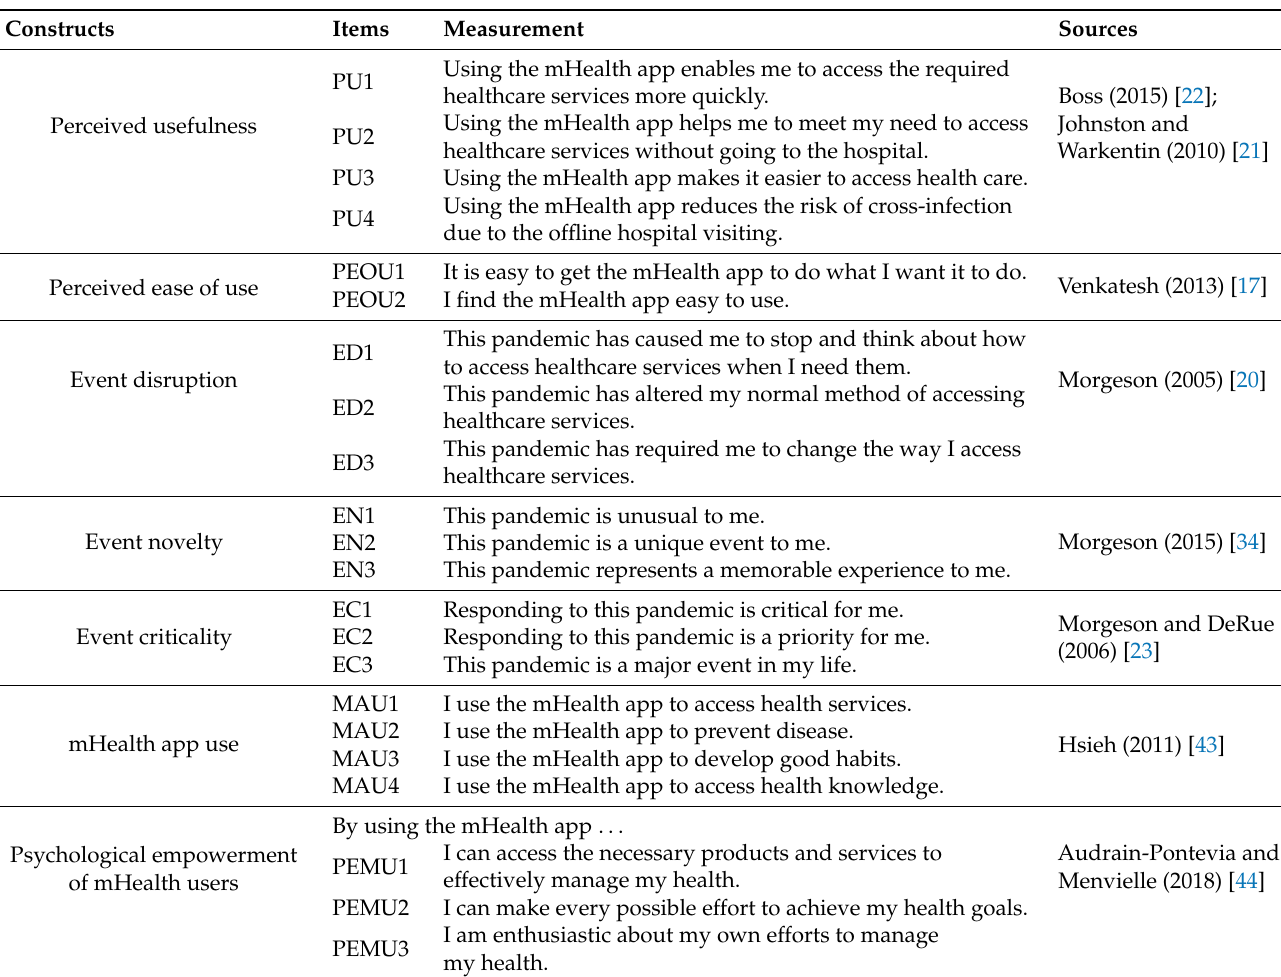
Table A1. Constructs and Measurement Items.